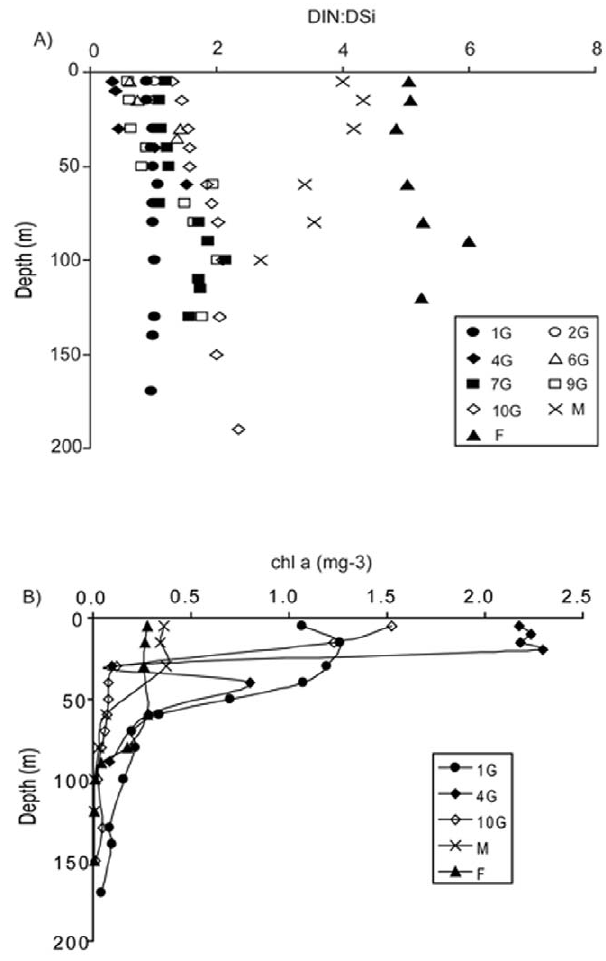
Figure 5. N:Si ratio and Chl a profile. (a) N:Si in the water column as a function of depth at all stations, (b) Chl a depth profile in mg m 2 3 at the two open ocean and three of the shelf stations.